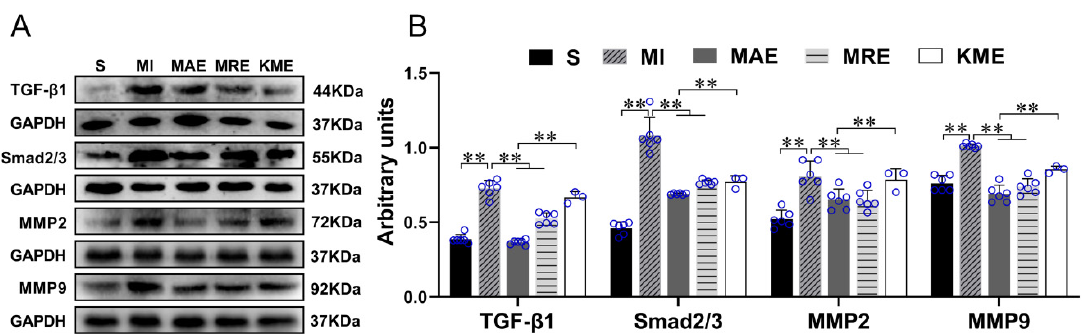
Figure 5. Exercise training inactivated the TGF- β 1-Smad2/3-MMP2/9 signaling pathway via FGF21. ( A ) The protein expressions of TGF- β 1, Smad2/3, MMP2 and MMP9. ( B ) Statistical analysis. Data are expressed as mean ± Standard Deviation (SD), n = 8 in S, MI, MAE and MRE groups and n = 4 in KME group. Statistical method: one-way analysis of variance (ANOVA). ** p < 0.01. S, Sham group; MI, MI-sedentary group; MAE, post-MI aerobic exercise training group; MRE, post-MI resistance exercise training group; and KME, the Fgf21 KO mice with aerobic exercise training